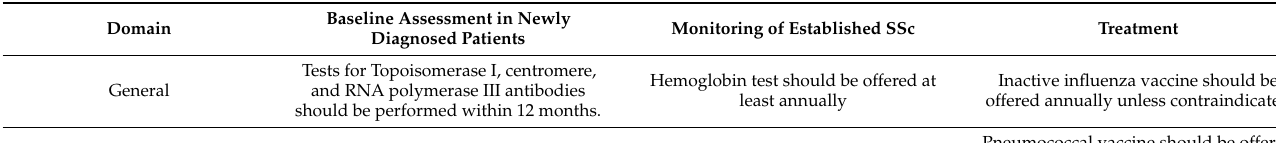
Table 2. Systemic sclerosis process of care quality indicators derived from physicians for use in the US healthcare